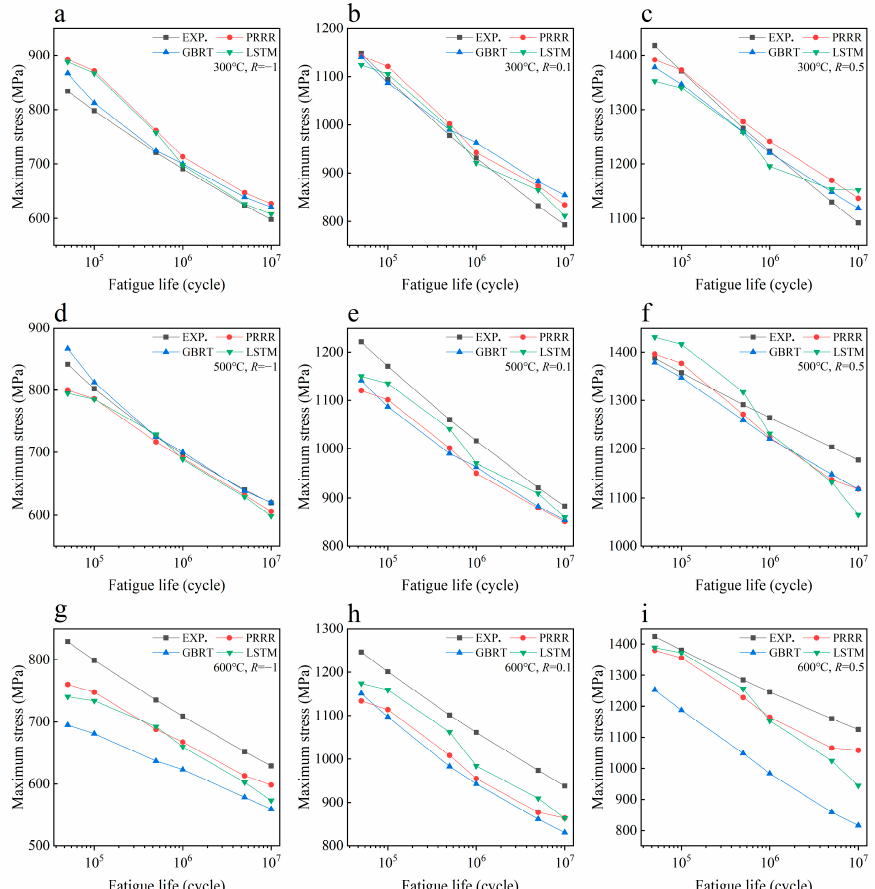
Figure 7. Predicted results of different machine learning models for the fatigue strength of the nickel ‐ based superalloy under different conditions in case 3: ( a ) 300 °C, R = − 1; ( b ) 300 °C, R = 0.1; ( c ) 300 °C, R = 0.5; ( d ) 500 °C, R = − 1; ( e ) 500 °C, R = 0.1; ( f ) 500 °C, R = 0.5; ( g ) 600 °C, R = − 1; ( h ) 600 °C, R = 0.1; ( i ) 600 °C, R = 0.5.